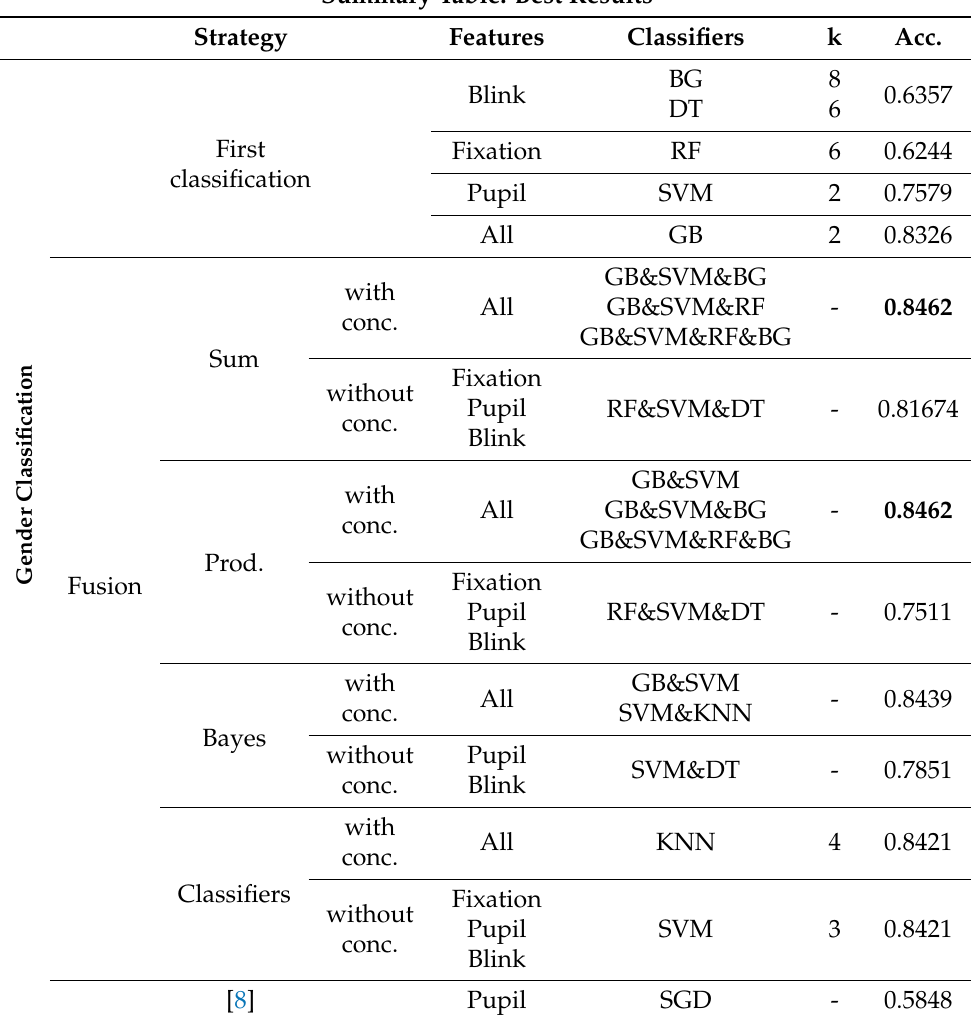
Summary Table: Best